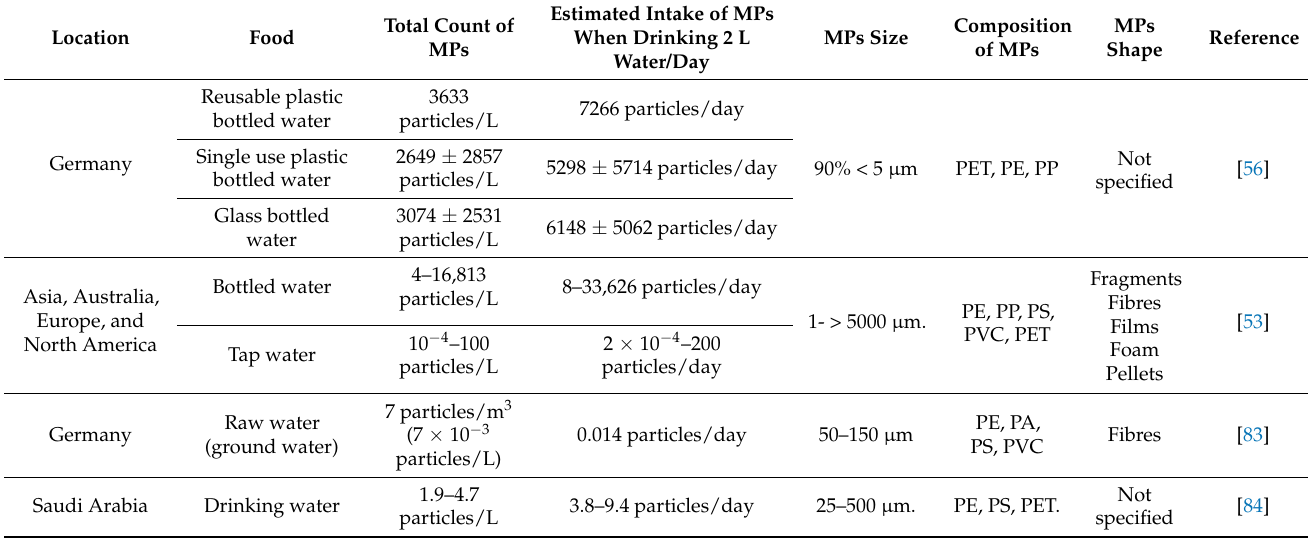
Table 1. MPs levels in different drinking waters and estimated dietary intake in a 2 L water/day consumption scenario.